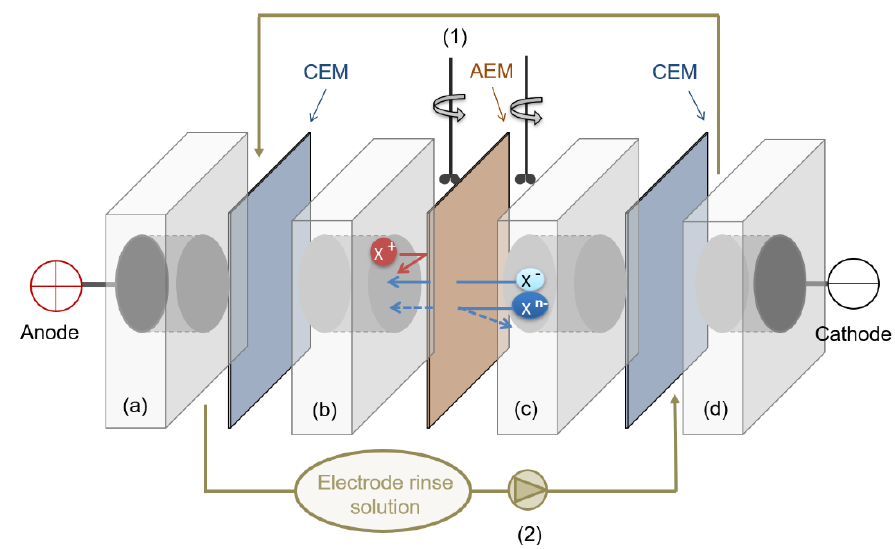
Figure 1. Experimental set up employed for the evaluation of membrane transport properties. CEM: cation exchange membrane (Neosepta CMX). EM: anion exchange membrane (under analysis). Electrodes: dimensional stable electrodes (ti / mixed metal oxides). Electrode compartments ( a , d ): 5 cm-thickness, 28.27 cm 2 cross-sectional area, 3.6 L · h − 1 flow rate. Concentrate ( b ) and dilute ( c ) compartments: 5 cm-thickness, 19.64 cm 2 cross-sectional area, under stirring. (1) Mechanical rod stirrer, (2) peristaltic pump.